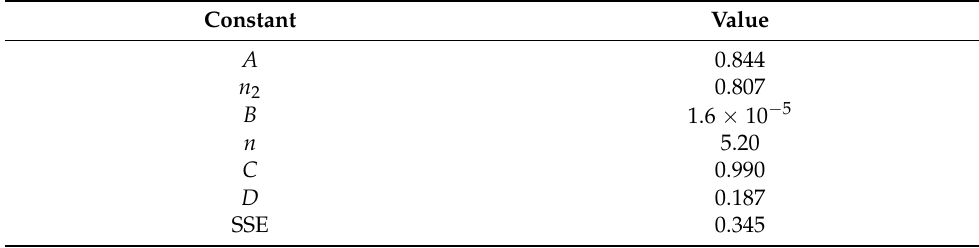
Table 4. Curve-fit constants for correlation of two-pad FH data (Equation (8)). Constant